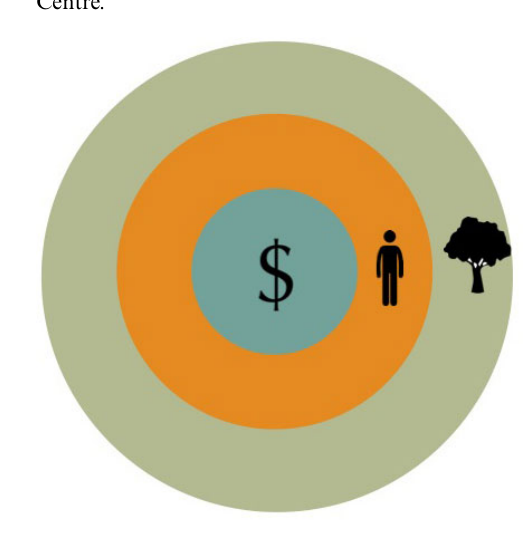
Fig. 2 . Economic and social elements must